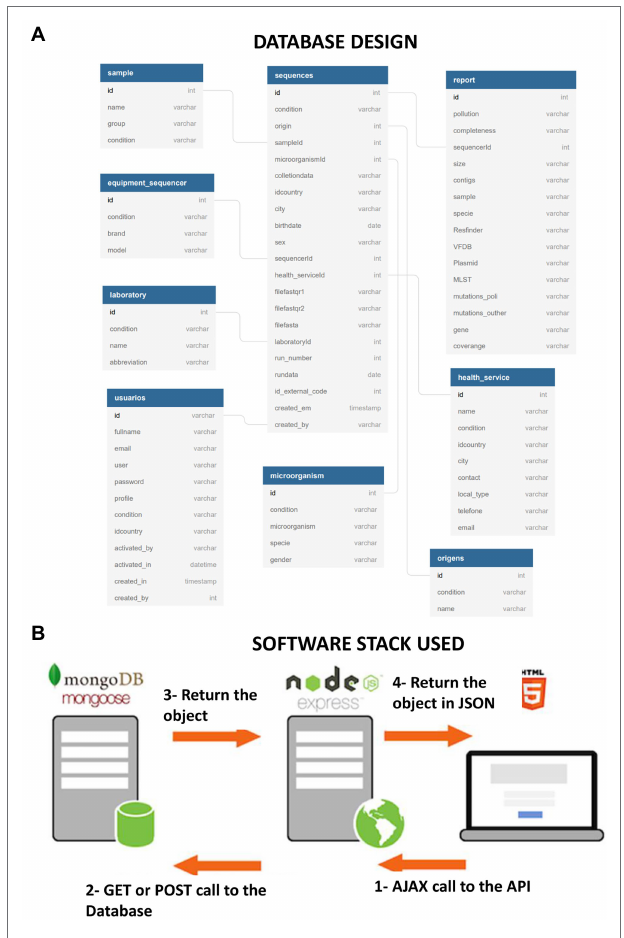
FIGURE 2 | (A) NoSql Database Design—MongoDB. (B) Web Application Architecture: From the frontend, with html5 we make AJAX calls to our API on the Node server. This consults the database (Mongo) depending on the call made. The DB returns the object as a response to Node and Node serves it as JSON to Html5 that displays it on the frontend without the need to reload the page, thus creating a Single Page Application